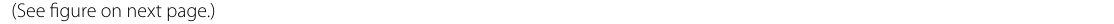
Fig. 3 Expression of tyrosine hydroxylase (th) and fin movement frequency in ccdc141 and vstm2l morphants. In situ hybridization was conducted with tyrosine hydroxylase antisense RNA probe. At 3 dpf, ( A ) in ccdc141 5’UTR (MO1) morphants, the distribution of th is dispersed and the th ‑expressing amacrine cells (red arrows) are decreased; in vstm2l splicing (MO2) morphants, lower th expression in dorsal pretectum (red asterisk), DC7 neurons (red square) and amacrine cells was observed; and the distribution of th in sympathetic superior cervical ganglion (SCG, green rectangle) is decreased and dispersed. Of note, the th expression in locus coeruleus (LC) and medulla oblongata (MeO) neurons does not alter. For quantification before th in situ experiments, the morphants were separated into groups according to their phenotypic severity. The results showed that fewer th ‑expressing amacrine cells were observed in every group, including wt‑like (P1) group in ( B ) 4.5 dpf ccdc141 MO1 morphants and ( C ) 4 dpf vstm2l MO2 morphants, whose statistical data are shown in ( D ) embryos injected with 1 ng ccdc141 MO1 morpholino and ( E ) embryos injected with 16 ng vstm2l MO2 morpholino, respectively. Note that ( F ) amacrine cell deceasing phenotype was rescued by co‑injecting ccdc141 mRNA into ccdc141 morphants. G Hyperkinetic movements were observed in vstm2l MO2 morphants with significant differences. H The ccdc141 MO1 morphants had a trend of hyperkinetic movements, though the P value was not significant. (In these experiments, ccdc141 MO1 morphants were injected with 0.5 ng ccdc141 MO1 morpholino, and vstm2l MO2 morphants were injected with 16 ng vstm2l MO2 morpholino. Only wild‑type like embryos were used to conduct experiments.) (N number for ( A ) AB 2, ccdc141 MO1_1ng 7, AB 4, vstm2l MO2_16ng 41, vstm2l MO2_16ng_ = = = = severe phenotype 9. ( D ) AB 5, MO‑P1 6, MO‑P2 24, MO‑P3 2, MO 32. ( E ) AB 13, MO‑P1 6, MO‑P2 17, MO‑P3 11, MO‑P4 4, = = = = = = = = = = = MO 38. ( F ) AB 21, MO1 18, MO1 mRNA 25. G vstm2l AB 5, vstm2l MO2 4. H ccdc141 AB 10, ccdc141 MO1 9.) (Mann–Whitney U test = = = + = = = = = was used for comparisons of unpaired nonparametric variables. All calculated P ‑values were two‑tailed, and statistical significance was defined as P ‑value less than 0.05. Symbol meaning: *, p 0.05; **, p 0.01; ***, p 0.001; ****: p ≤ ≤ ≤